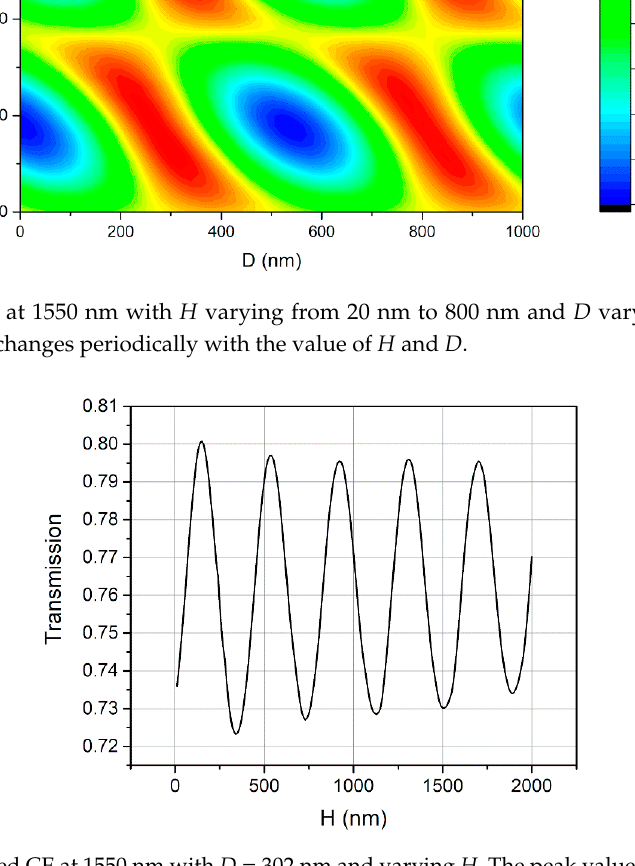
Figure 7. Calculated CE at 1550 nm with D = 302 nm and varying H . The peak value of the CE is slowly decreasing while H is increasing.